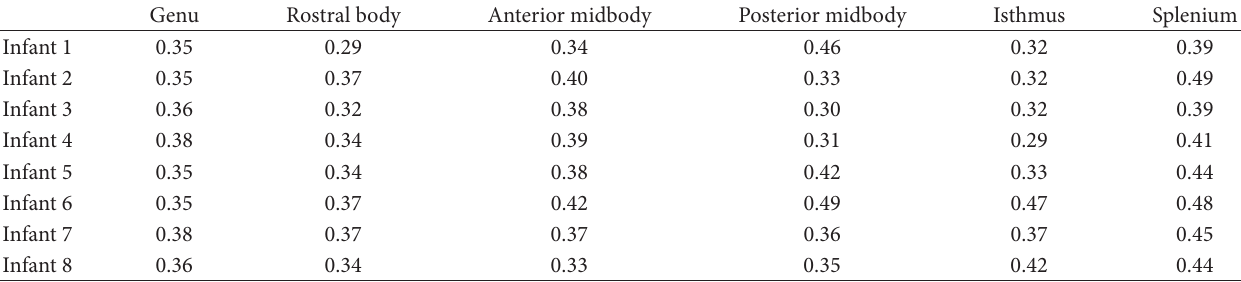
T 2: Corpus callosum fractional anisotropy values for each infant.